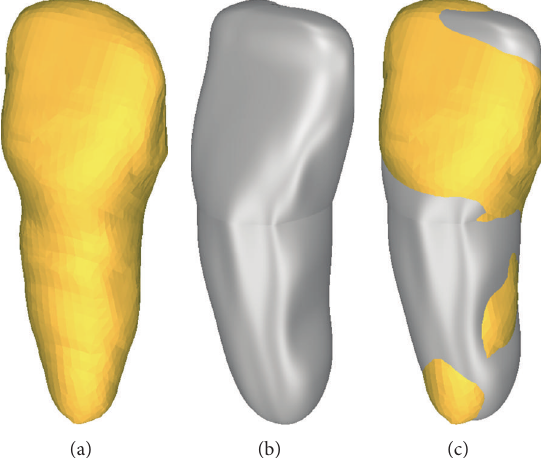
Figure 6: Tooth 2.1. segmented and extracted from cone beam (a), parametric model obtained with PAN measures (b), and superim- position of the models from a buccal vision (c).